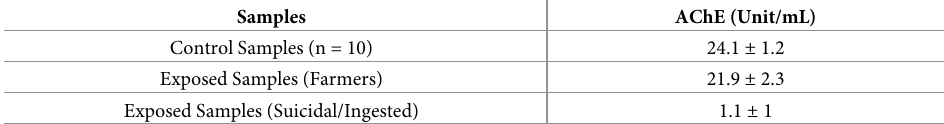
Table 4. AChE levels estimated in human blood samples of control and exposed.